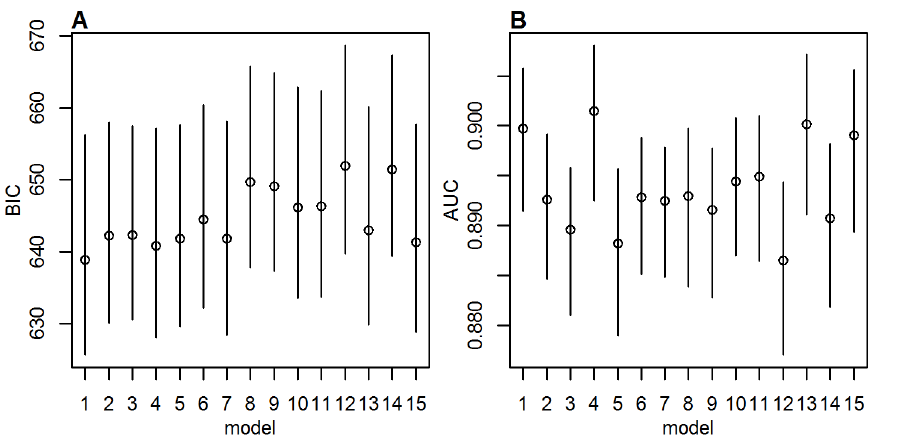
Figure 2. Goodness of fit measures. (A) BIC and (B) AUC values for the 15 models investigated with MCMC, with a prior standard deviation on the country factors of 2. Circles show posterior means, lines the 95% posterior range.